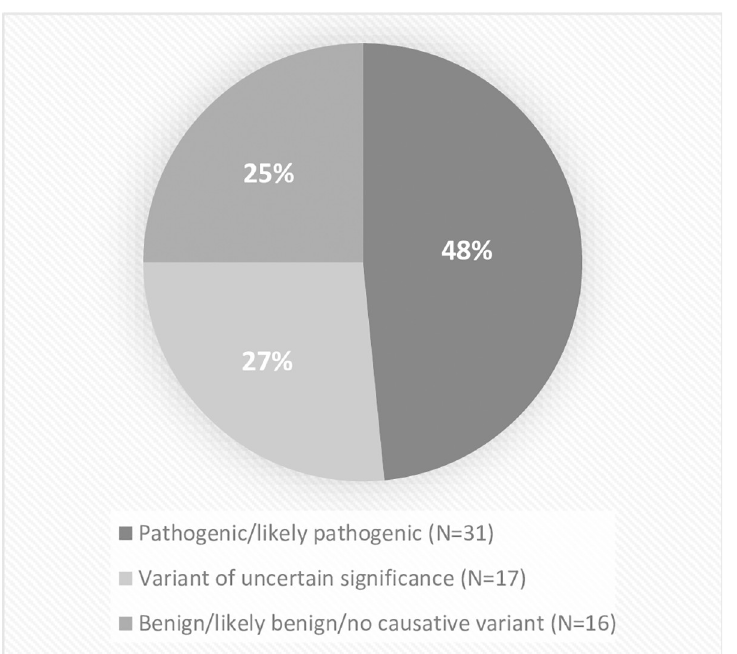
Fig 2. Interpretation of detected genetic variants in adult